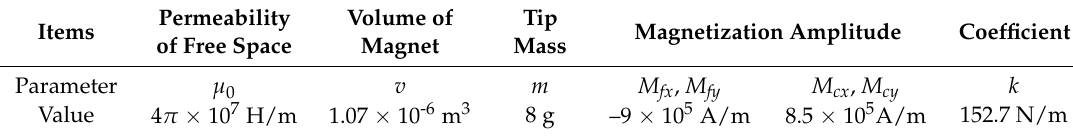
Table 1. Parameters of the energy